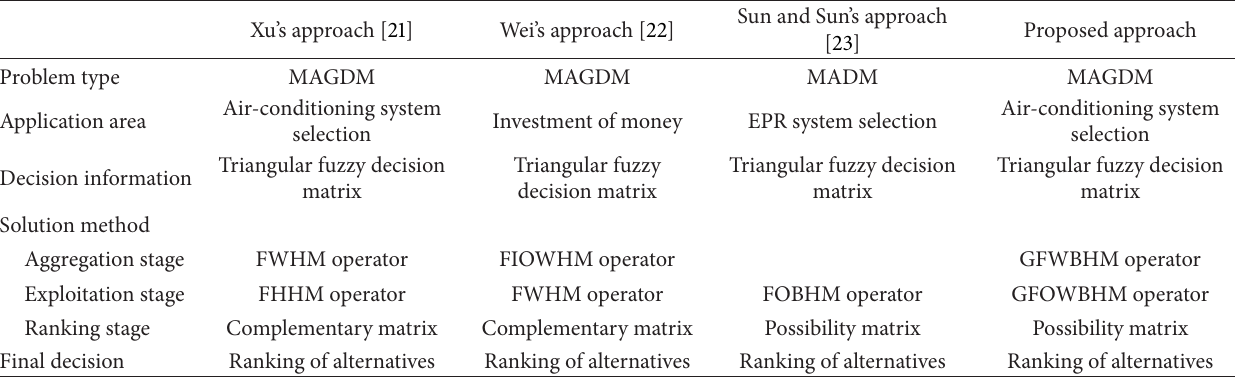
Table 7: Comparison of the proposed approach with other